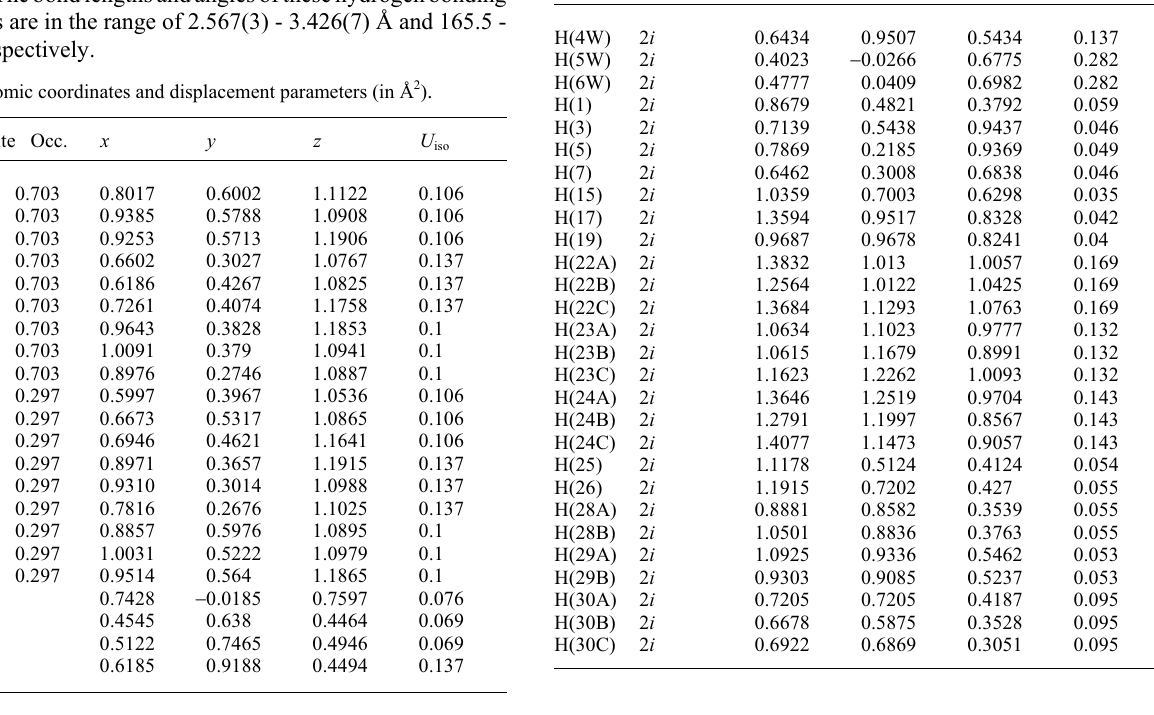
Table 3. Atomic coordinates and displacement parameters (in Å 2 ) .